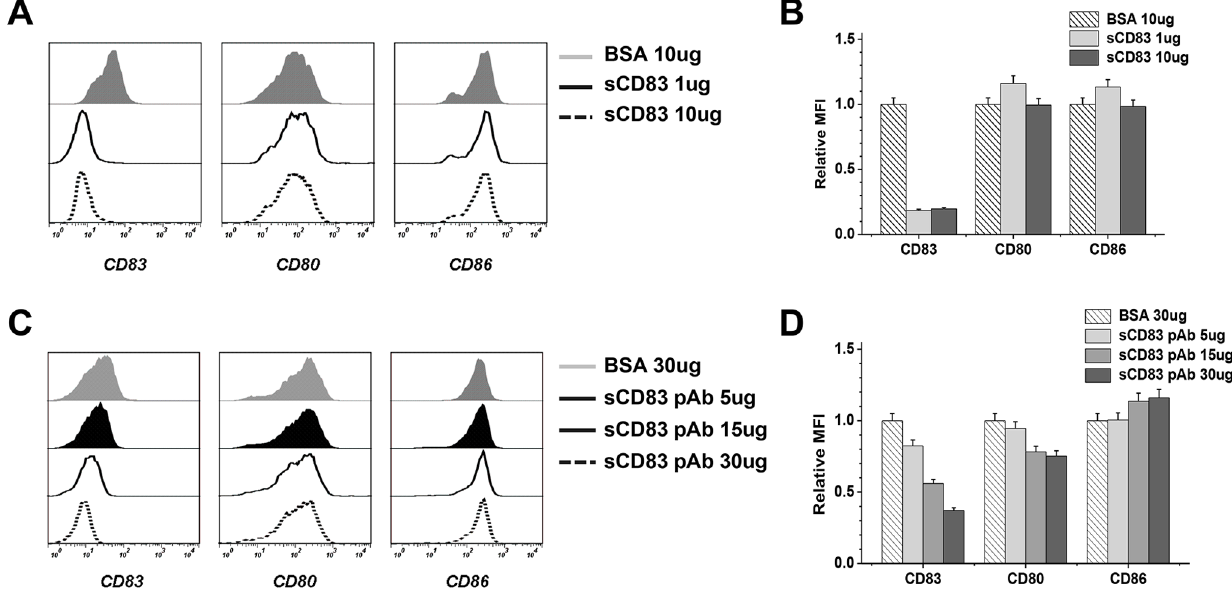
Figure 5. The specificity detection of sCD83. sCD83 has the similar epitope as the membrane form. (A, B) FACS competition tests of sCD83. Mature DCs were coated with the indicated antibody for DC surface molecules, and the indicated concentration of sCD83 was added. Representative FACS histograms are shown. (B) The data are from (A) an experiment that is representative of at least 3 independent experiments. (C, D) FACS competition tests of an anti-sCD83 pAb. Mature DCs were coated with the indicated antibody for DC surface molecules, and the indicated concentration of sCD83 polyclonal antibody was added. Representative FACS histograms are shown. (D) The data are from (C) an experiment that is representative of at least 3 independent experiments. The means 6 the standard error of the mean (SEM) of the MFI are shown (B, D).